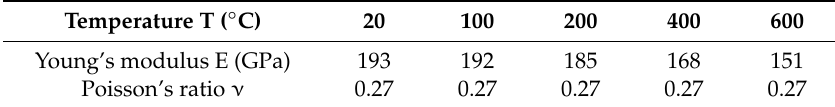
Table 5. Temperature-dependent Young’s modulus and Poisson’s ratio of the sintered stainless steel 316L [32].